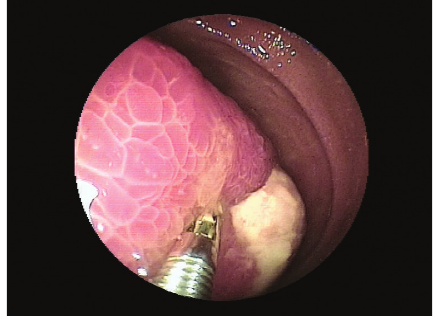
Figure 3: Jejunal hamartoma; the size of the polyp is nicely seen in DBE fluoroscopy.